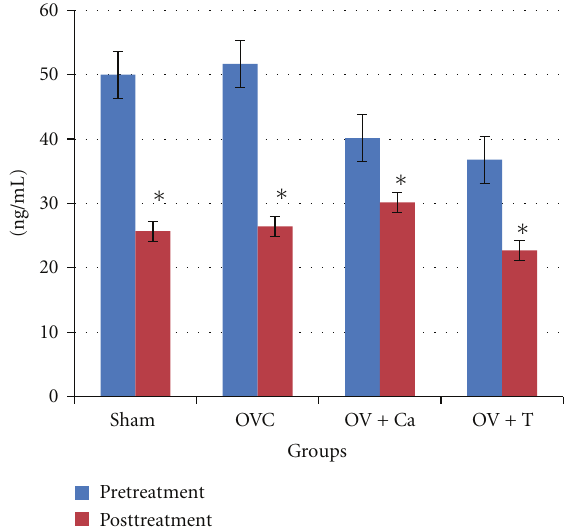
Figure 6: Serum C-terminal telopeptide of type 1 collagen (CTX). Sham: sham-operated rats given deionised water and vehicle olive oil. OVC: ovariectomised rats given deionised water and vehicle olive oil. Ov+Ca: ovariectomised rats given 1% calcium in deionised water and vehicle olive oil. Ov+T: ovariectomised rats given deionised water and palm tocotrienol. ∗ indicates significant di ff erence before and after treatment ( P < 0 . 05).